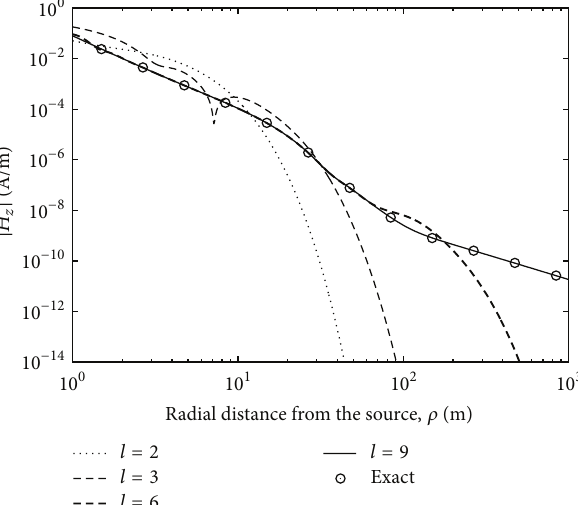
Figure 7: Profiles of |𝐻 𝑧 | against the radial distance from the source